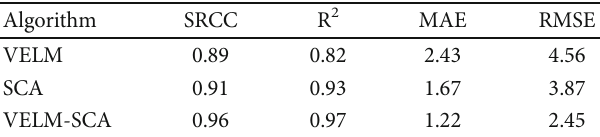
Table 2: VELM-SCA metric measures.